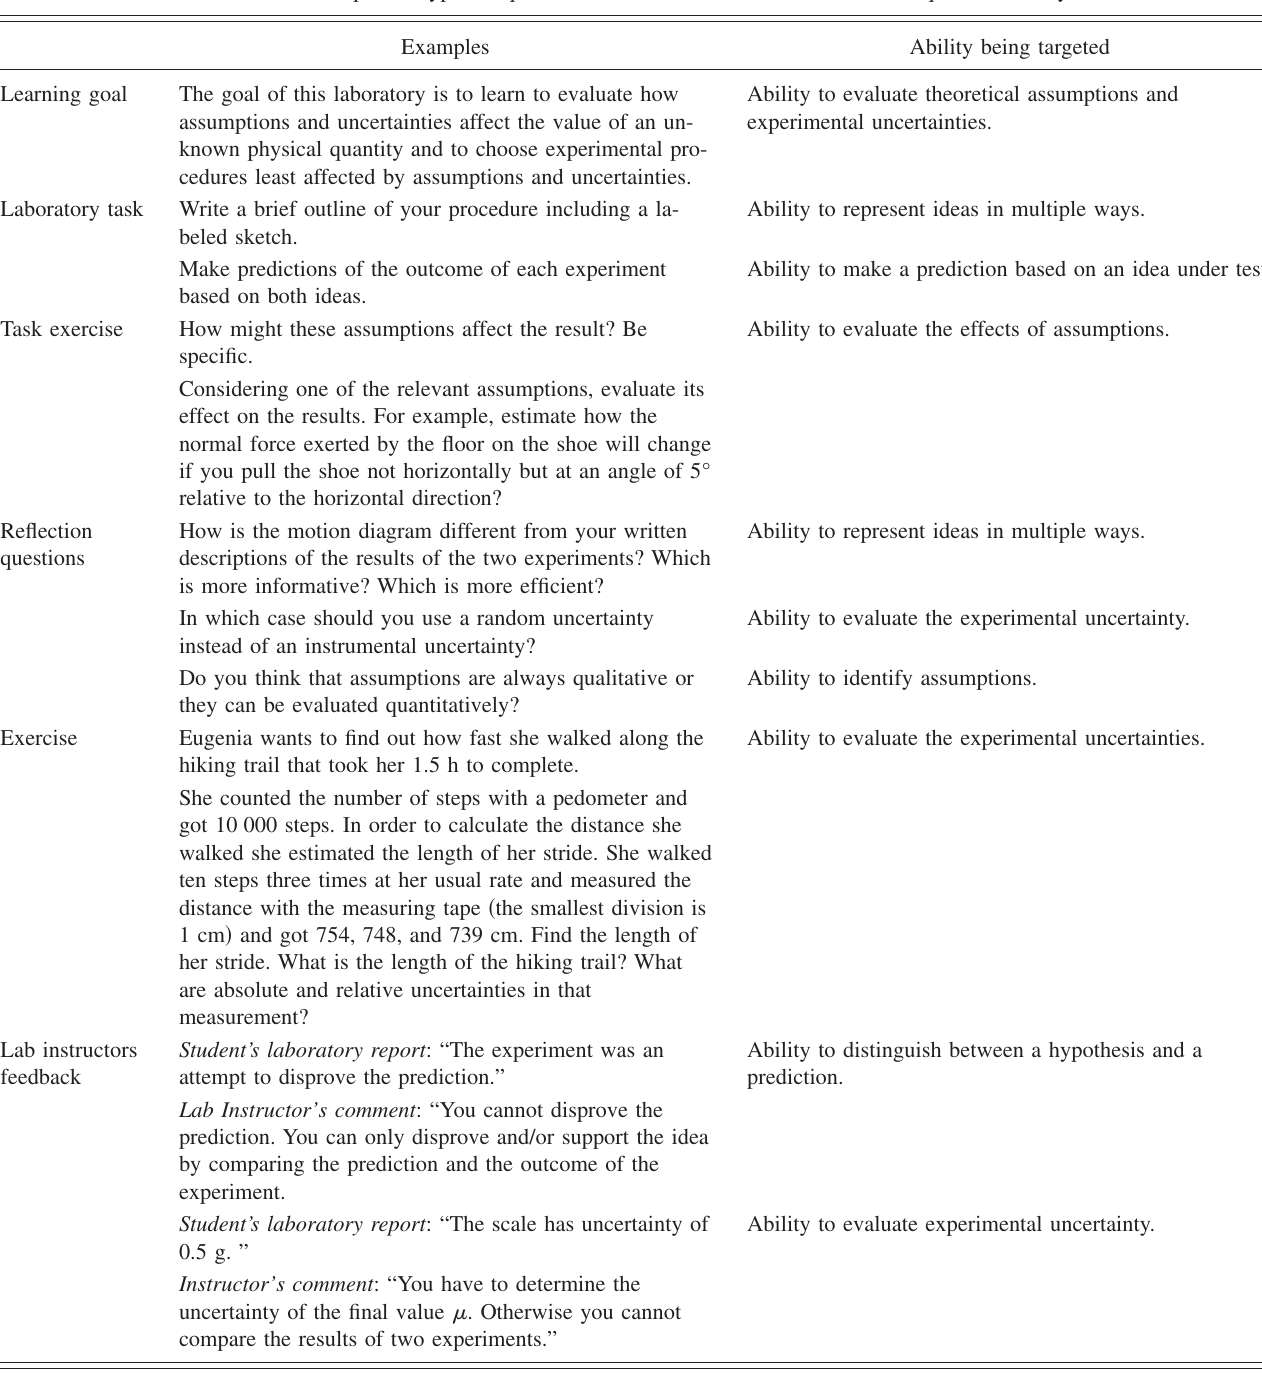
TABLE I. Examples of types of questions and exercises that students do to acquire the ability. Examples Ability being targeted Learning